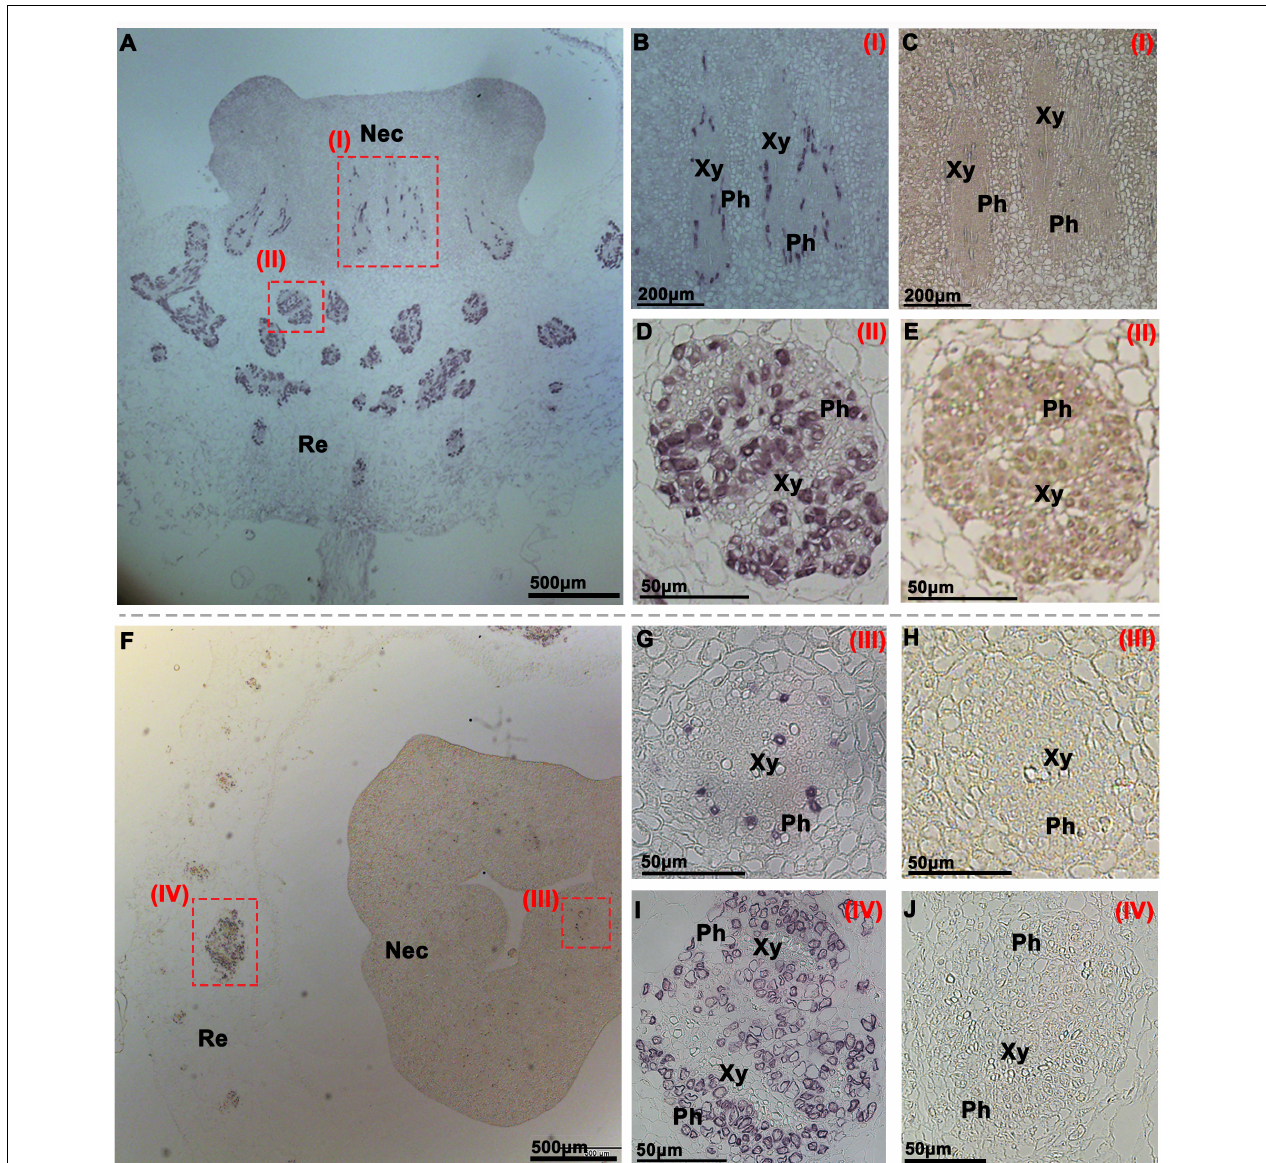
FIGURE 3 | Immunohistochemical localization of CsSWEET7a in male cucumber flowers. Longitudinal (A–E) and transverse sections (F–J) of male flowers with alkaline phosphatase (AP) as the second antibody. (B,D,G,I) The close-up of the boxes in panels (A,F) , respectively. (C,E,H,J) Sections incubated with pre-immune serum as a control. The Roman numerals in red at the top-right corner (B–E,G–J) correspond to the fields in panels (A,F) . Nec, nectary; Re, receptacle; Ph, phloem; Xy,